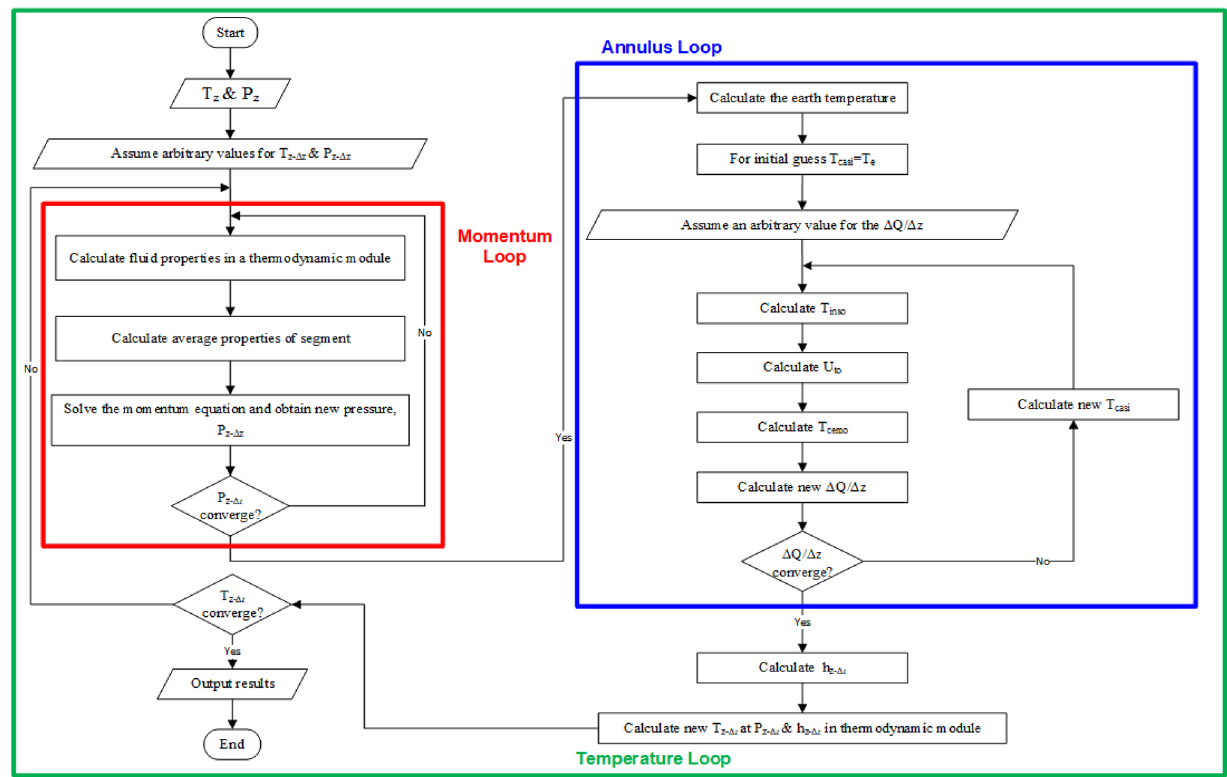
Fig. 3 Procedure for calculating the pressure and temperature profiles along the